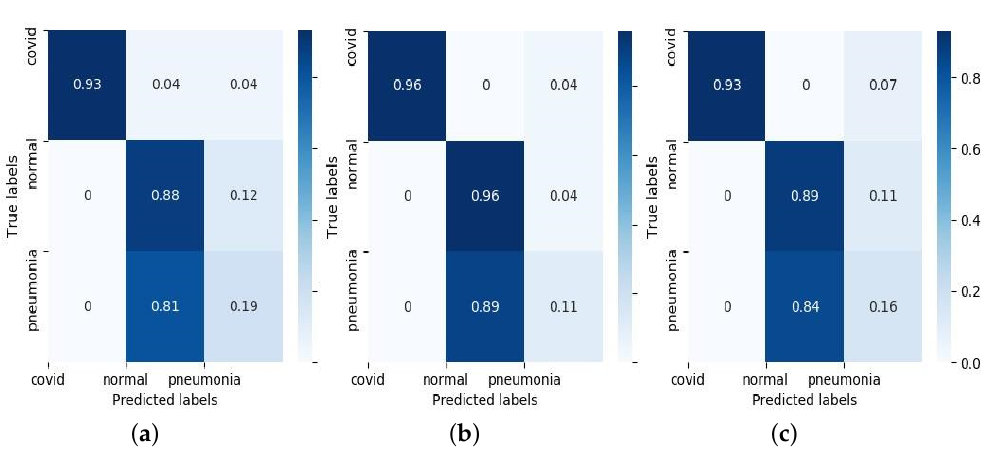
Figure 6. Overlapped and 5-fold confusion matrix results for ( a ) 5 LCs, 5 ILCs, ( b ) 15 LCs, 2 ILCs, and ( c ) 15 LCs, 5